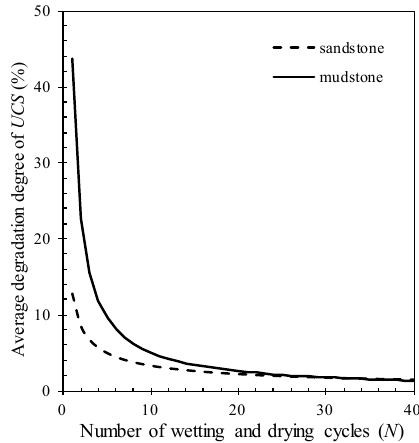
Figure 14. Fitted curves of average degradation degree of UCS and wetting and drying cycles.